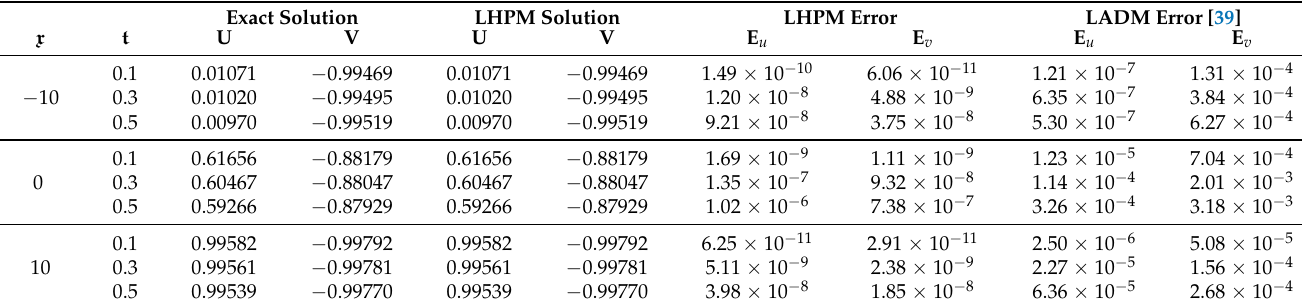
Table 3. Comparison of LHPM solution and error in Example 2 when β = 1 and η = a = 0.5 (where E u and E v represents errors of U and V , respectively).